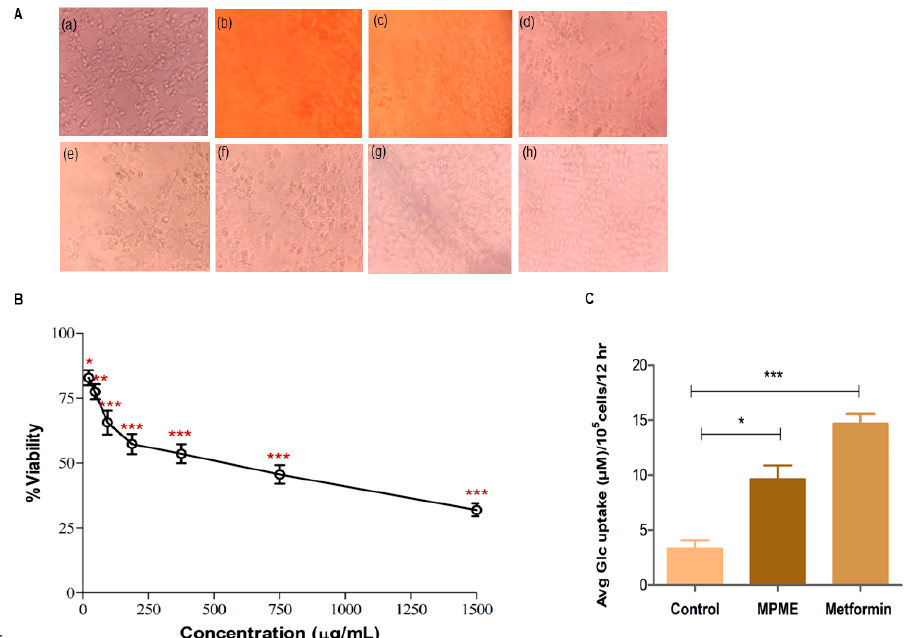
Figure 2. ( A ) Morphological changes in HepG2 cells after MPME treatment for 24 h. Untreated (Con- trol) ( a ), Methanolic heartwood extract of Pterocarpus marsupium (MPME) (1500 µg/mL) ( b ), MPME (750 µg/mL) ( c ), MPME (375 µg/mL) ( d ), MPME (187.5 µg/mL) ( e ), MPME (93.75 µg/mL) ( f ), MPME (46.87 µg/mL) ( g ), MPME (23.43 µg/mL) ( h ). ( B ) Effect of MPME on HepG2 cell viability analyzed by 3-(4,5-dimethylthiazol-2-yl)2,5-diphenyl tetrazolium bromide (MTT) assay. Cells were exposed to increasing concentrations of MPME from 1500 µg/mL to 23.43 µg/mL for 24 h. Data are repre- sented as means [±] standard deviation (SD) (n = 3). The asterisks (*) indicate statistical significant differences with the control (* p < 0.05, ** p < 0.01, *** p < 0.001, ns p ˃ 0.5). ( C ) Effect of MPME (93.75 µg/mL) on glucose uptake in HepG2 cells for 24 h. Data were analyzed by unpaired, two-tailed, t - test and presented as (±) standard error of mean (SEM) (n = 3) with significance * p < 0.05, *** p < 0.001 compared to untreated control. rescein Diacetate (DCFDA) Probe by Flow Cytometry Measurement of ROS production is a clear sign of free radical-induced cell damage observed by non-fluorescent dye DCFH-DA. The ability of MPME to rescue H 2 O 2 -induced ROS production in HepG2 cells was quantified by measuring the fluorescence intensity of reacting DCFH and oxidative substrates. The fluorescent intensity of induced cells signif- icantly increased when compared to untreated control cells. MPME (23.43, 46.87, and 93.75 µg/mL) retained high cell viability, and when added to H 2 O 2 -induced HepG2 cells, a sig- nificant reduction in fluorescent intensity was observed in a dose-dependent manner com- pared to untreated (control) cells (Figure 3).